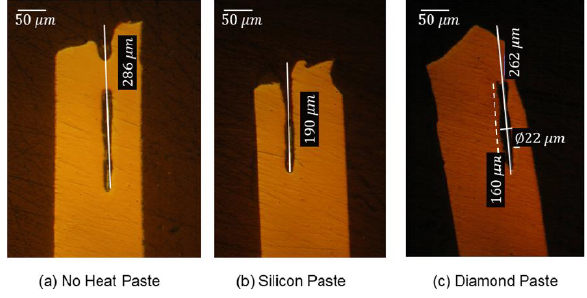
Figure 9: Microneedles with laser-drilled microholes using one group of three 10 µ s pulses, with different heat conductive pastes.